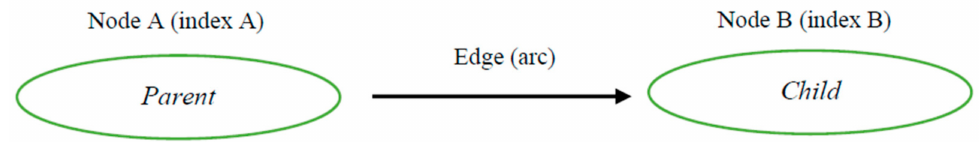
Figure 6. Causal relationships indicated by the